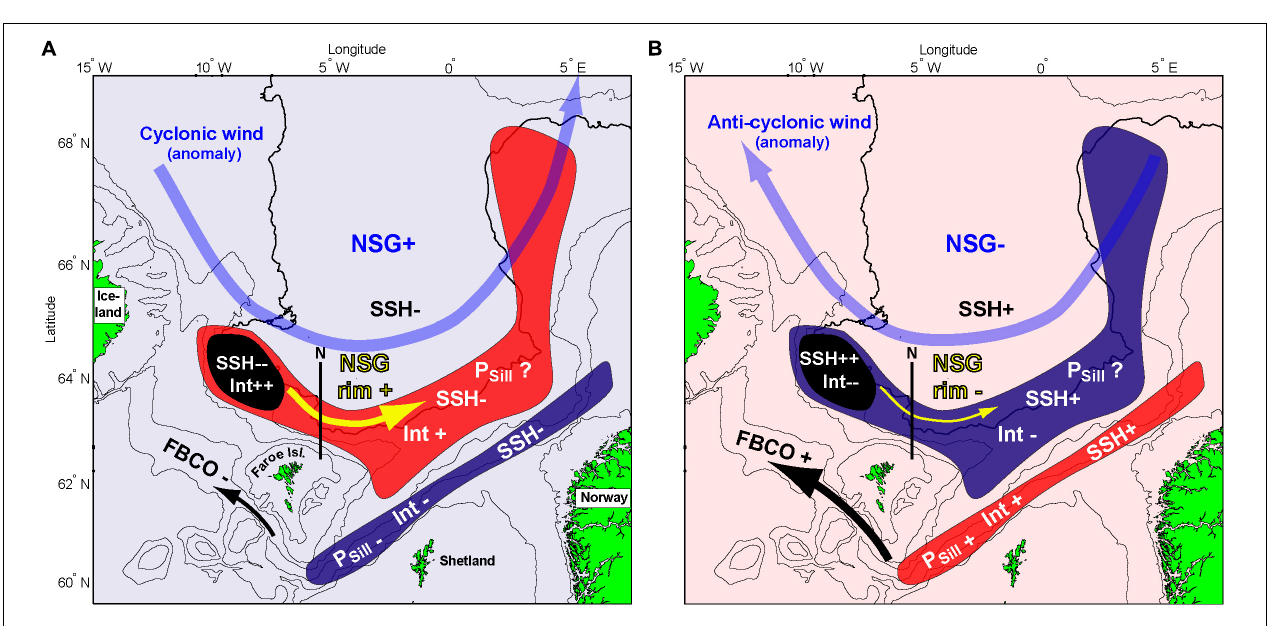
FIGURE 10 | A schematic of key element under contrasting (A) NSG+ and (B) NSG– states. “Int” refers to the interface height and P Sill refers to the pressure at depth levels of the Faroe Bank Channel sill ( ∼ 850 m). The other abbreviations are provided in Table 1 . A “+” refers to a strong value, cyclonic anomaly or elevated level of both the interface and SSH, and opposite for a “–.” The weak background colors refer to the broad SSH contrasts, while the more strongly colored regions show the additional imprint of vertical interface